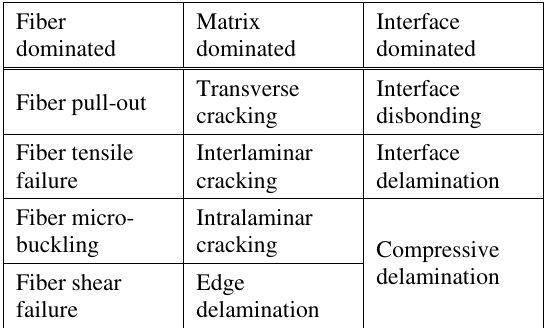
Table 3. Damage modes for laminate